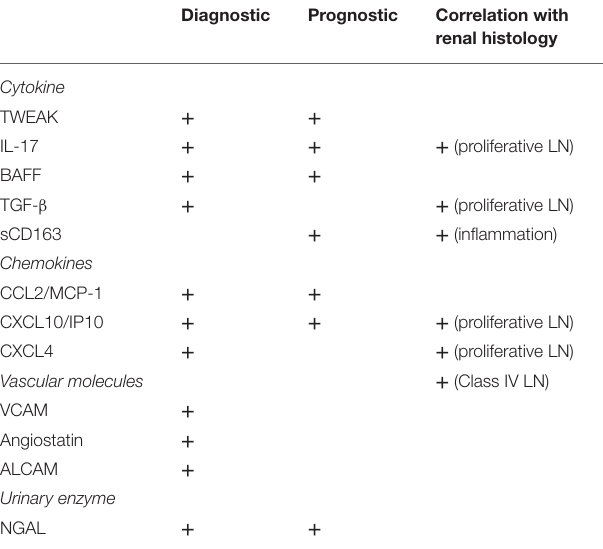
TABLE 1 | Some of the potential urinary